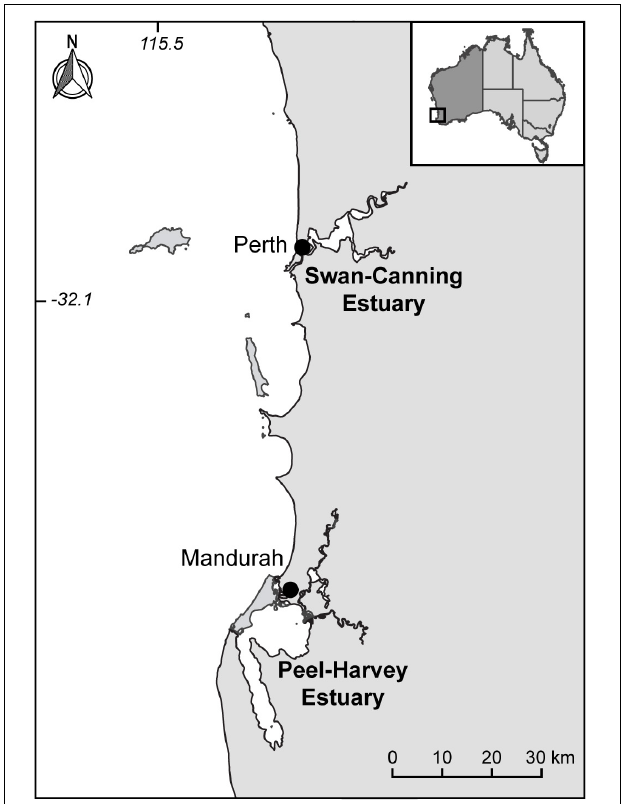
FIGURE 1 | Map of Western Australia (Australia), showing the location of the Peel-Harvey Estuary and the cities of Mandurah and